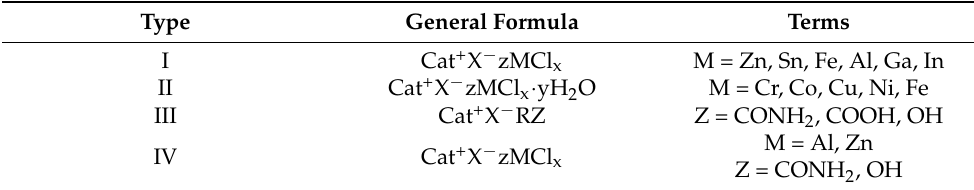
Table 6. Classification of deep eutectic solvents (adapted from Karivayev (2020) [139]).